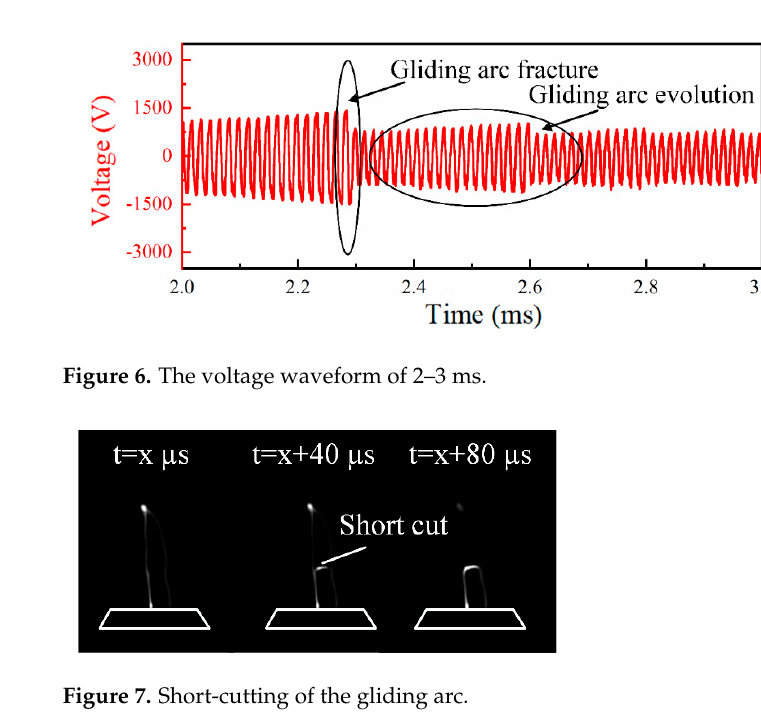
Figure 5. Voltage and current waveforms of gliding arc plasma igniter at Δ p = 350 Torr.